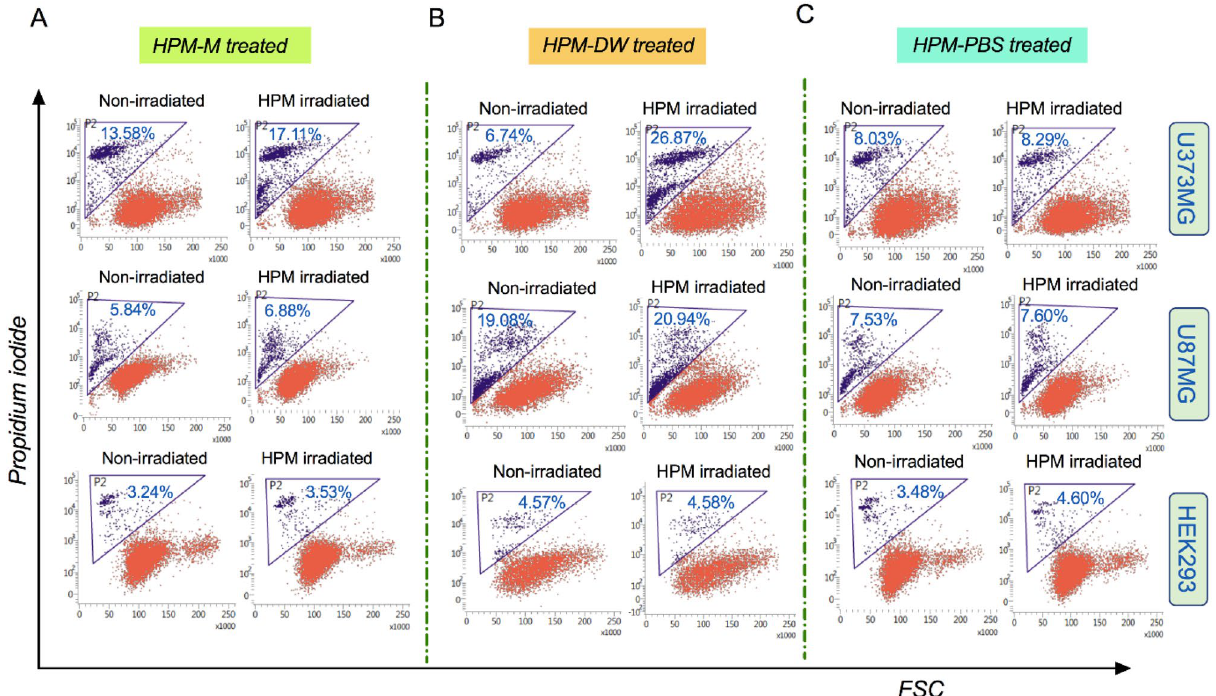
Figure 5. High power microwave-irradiated solutions and their impact on cell death. Representative FACS scatter plots showing cell populations bearing propidium iodide fluorescence, indicating its uptake. The groups represented are HPM-irradiated ( A ) Media, ( B ) DW, and ( C ) PBS. The data for U373MG, U87MG, and HEK293 cells are represented in the upper, middle and lower panel,